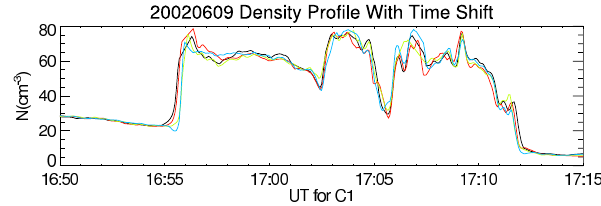
Fig. 11. Density profile during a plume crossing between 16:50 and 17:15UT on 9 June 2002. C2–4 data are shifted by − 48, − 64 and − 28s relative to C1 data, respectively. The colour scheme is the same as in Fig. 4.